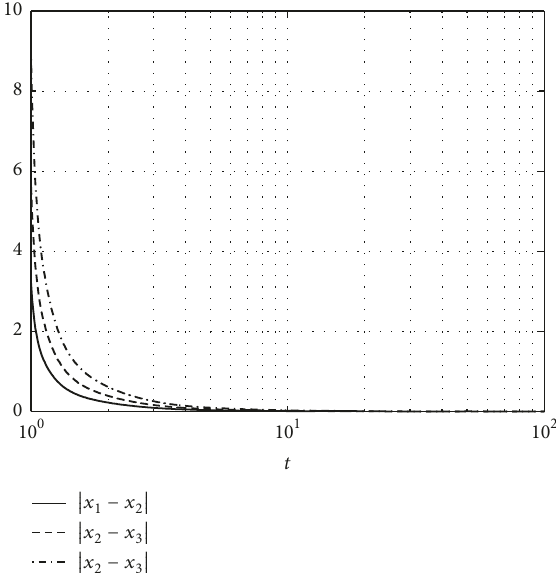
Figure 3: Linear case, 𝑗 = 2 .